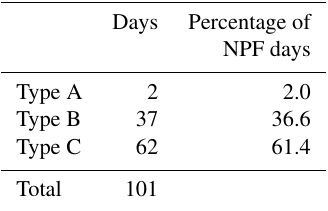
Table 4. NPF event classification statistics using size distribution results. Type A refers to days in which the formation and growth of particles were clear. Type B refer to days in which the formation oc- curred but the growth was not clear. Type C refers to days in which the event occurrence was